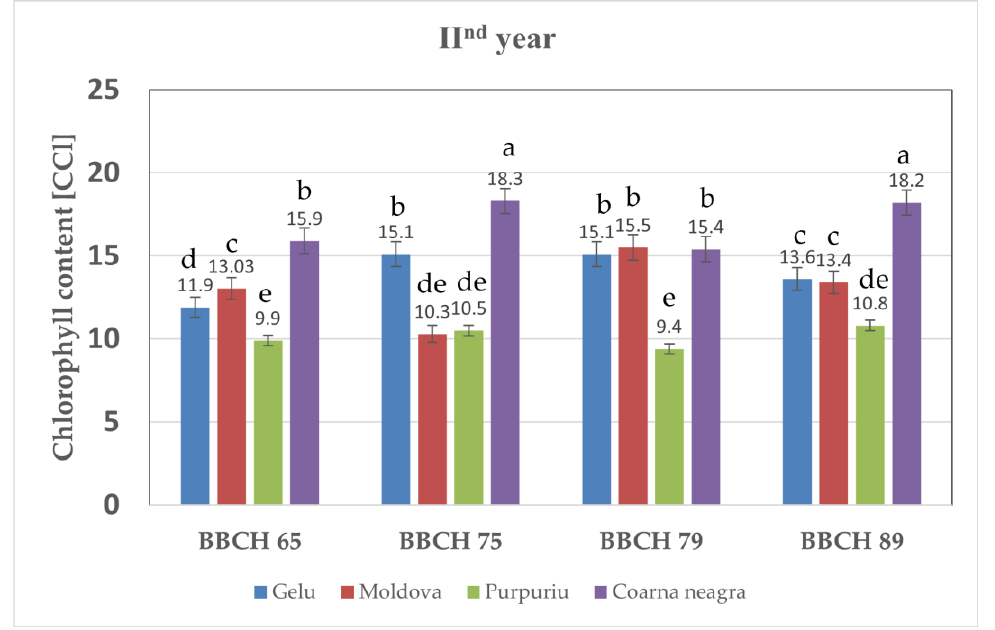
Figure 3. Dynamic evolution of the chlorophyll content (in CCl units) in the leaves of the four studied grapevine varieties in the second year with significant differences at 0.05 level indicated with letters.